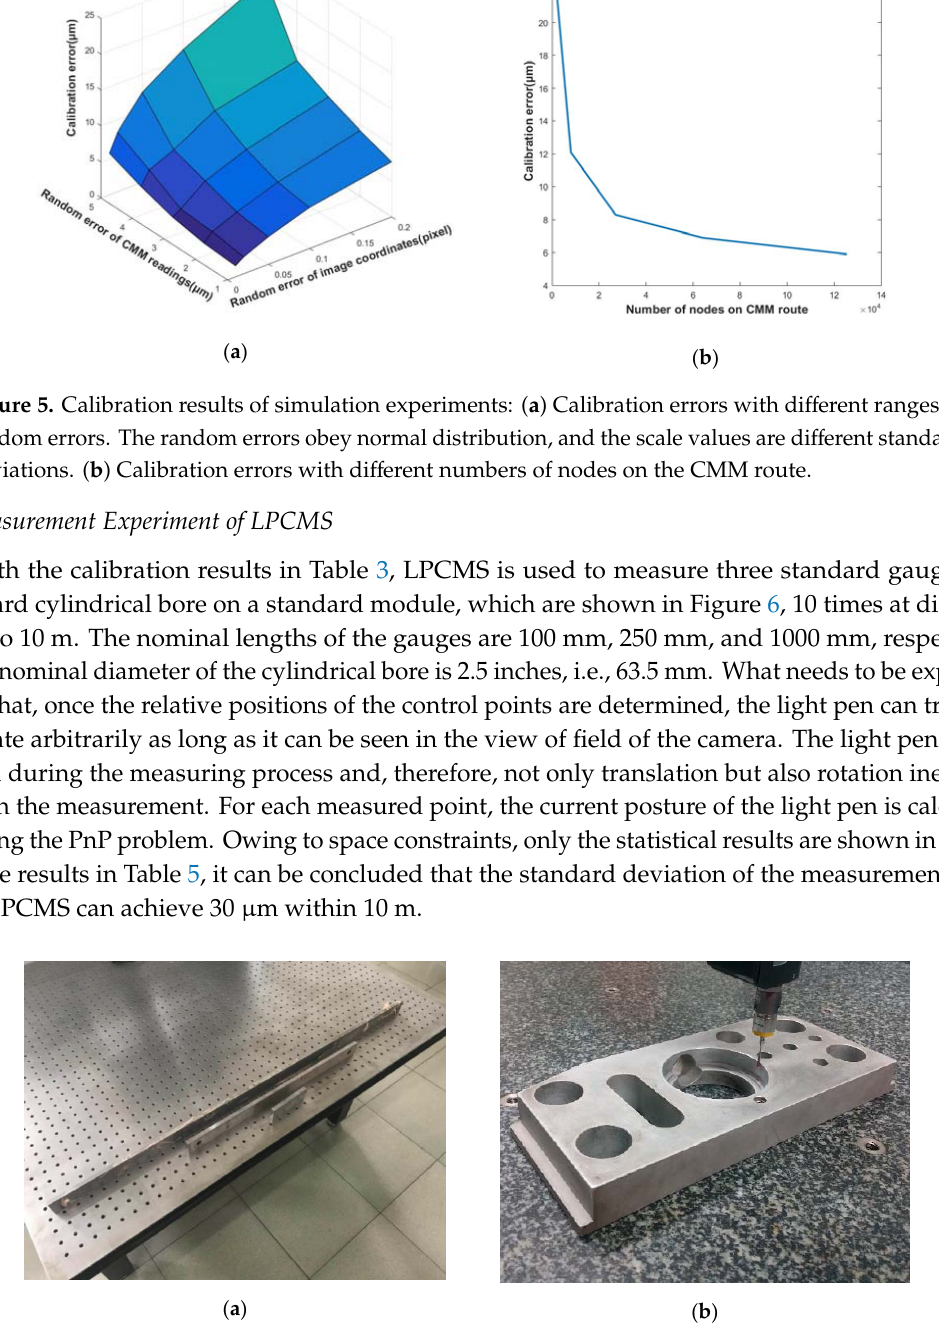
Figure 6. Measurement experiments of LPCMS: ( a ) Three gauges of different lengths; ( b ) a standard cylindrical bore. Table 5. The results of measurement experiment of LPCMS. The meanings of the abbreviations Ave and Std are the same as in Table 4 (mm).